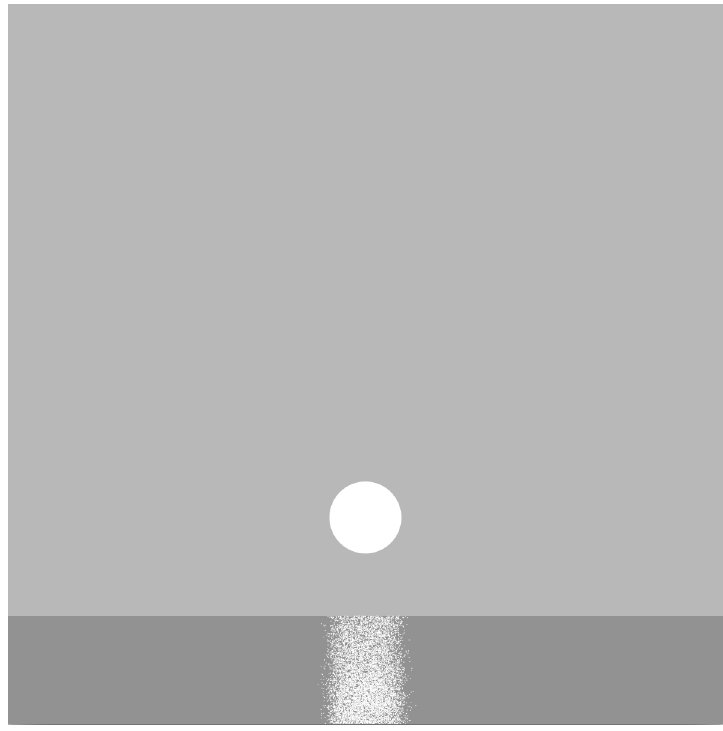
FIG. 5: Numerical simulation of the reflection at small angle of incidence of a light-emitting disc by a surface of randomly fluctuating